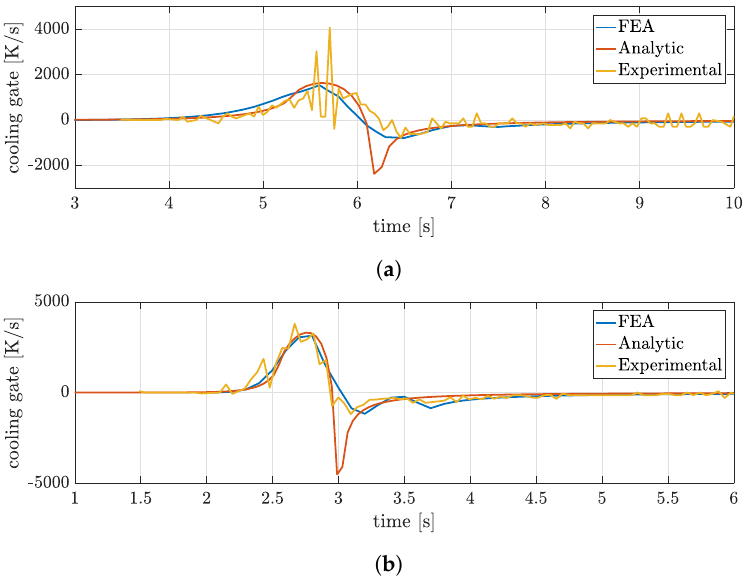
Figure 6. Comparison of the different cooling rate on the surface ( a ) P = 600 W, V = 0.2 m/min; ( b ) P = 600 W, V = 0.4